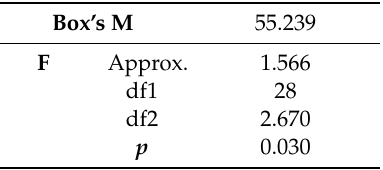
Table 3. Results from statistical testing.